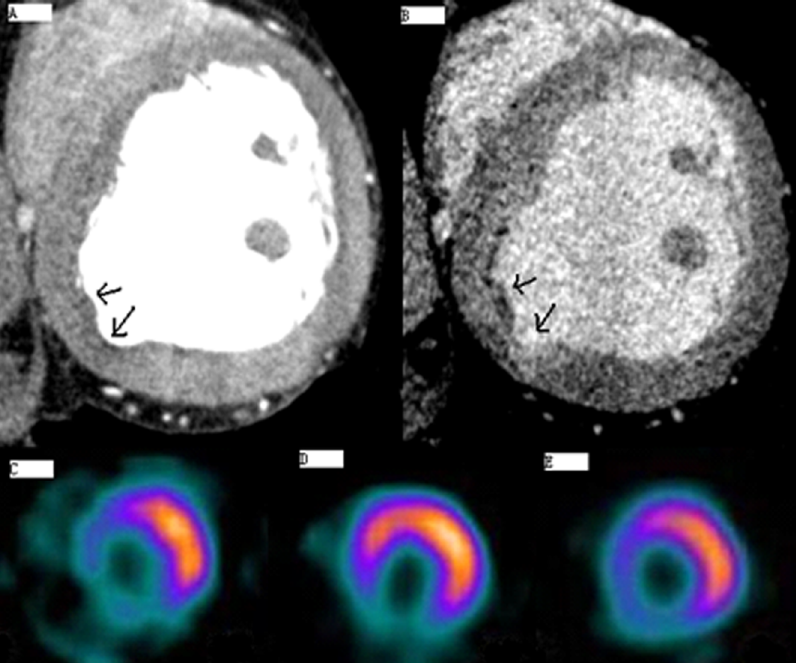
Figure 3. Representative Myocardial Perfusion Images of the Left Anterior Descending Coronary Artery (LAD) and Right Coronary Artery (RCA) using both MSCT and SPECT Examination. 3A: MSCT early scanning; 3B: MSCT late scanning; 3C: Stressed thallium-201 ( 201 TI)- SPECT imaging; 3D: 99m Tc-MIBI imaging; 3E: 201 TI-SPECT late resting image.